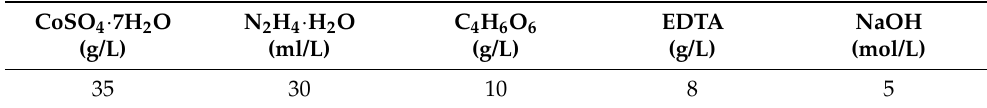
Table 2. Chemical composition of the plating solution.